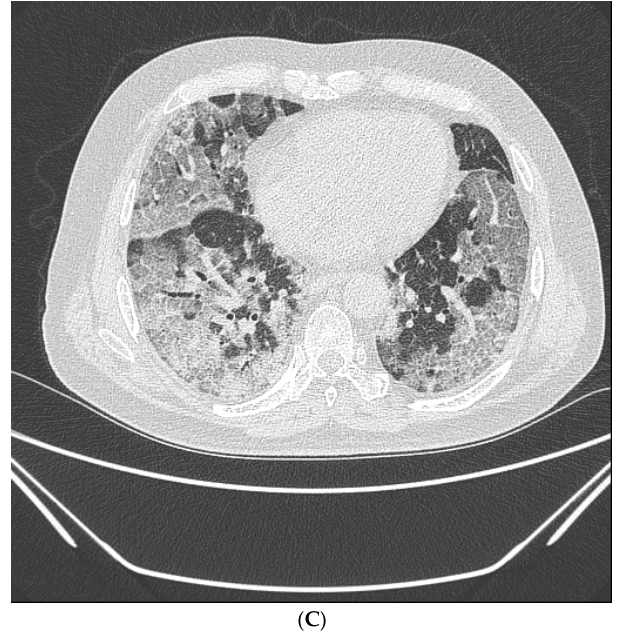
Figure 2. Typical findings for COVID-19 on CT scans. ( A ) Ground-glass opacity shows as a modest increase in lung attenuation on lung window CT images, not obscuring the pulmonary vessels. ( B ) Consolidation appears as high-density patchy opacities that obscure the margins of vessels and airway walls, inside which air bronchogram (arrow) could be observed. ( C ) Crazy-paving pattern appears as thickened interlobular septa and intralobular lines superimposed on a background of ground-glass opacity.